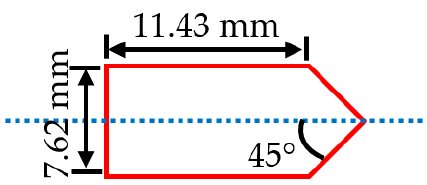
Figure 2. Schematic diagram of 7.62 AP Bullet steel core [13].